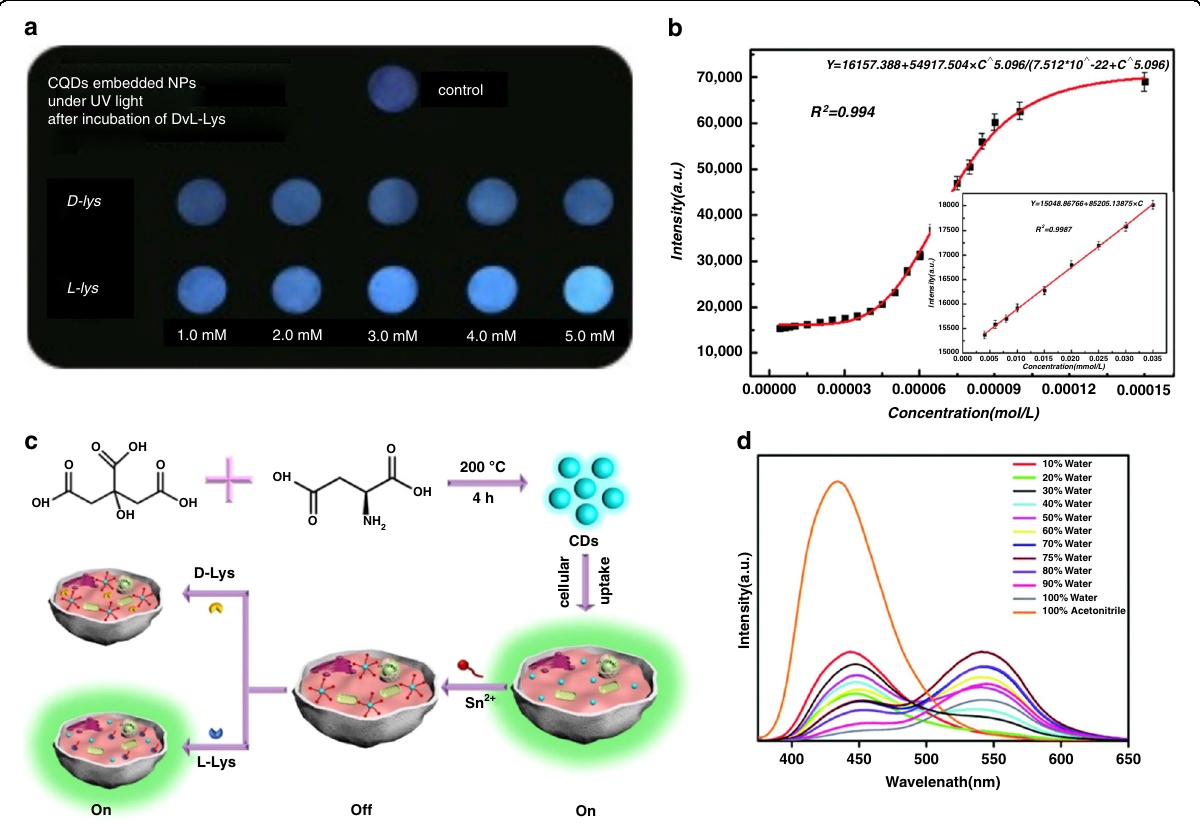
Fig. 7 Examples of sensing applications of chiral carbon dots. a Enantioselective sensor for L-/D-lysine; b Sensor for L-/D-arginine in nonlinear and linear (inset) concentration ranges; c On-Off-On sensor for Sn 2 + ions using L-/D-lysine capped carbons dots; d Moisture sensor. a Adapted with permission from 182 Copyright 2019 Elsevier. b Adapted with permission from 143 Copyright 2017 Royal Society of Chemistry. c Adapted